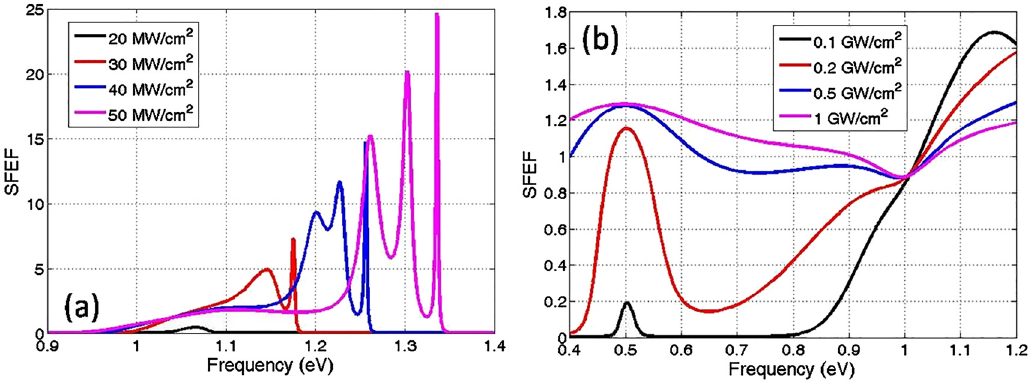
Figure 2: Spectral dependence of the squared-field enhancement factor (SFEF) for (a) moderate incident fi eld intensities and (b) higher incident fi eld intensities.